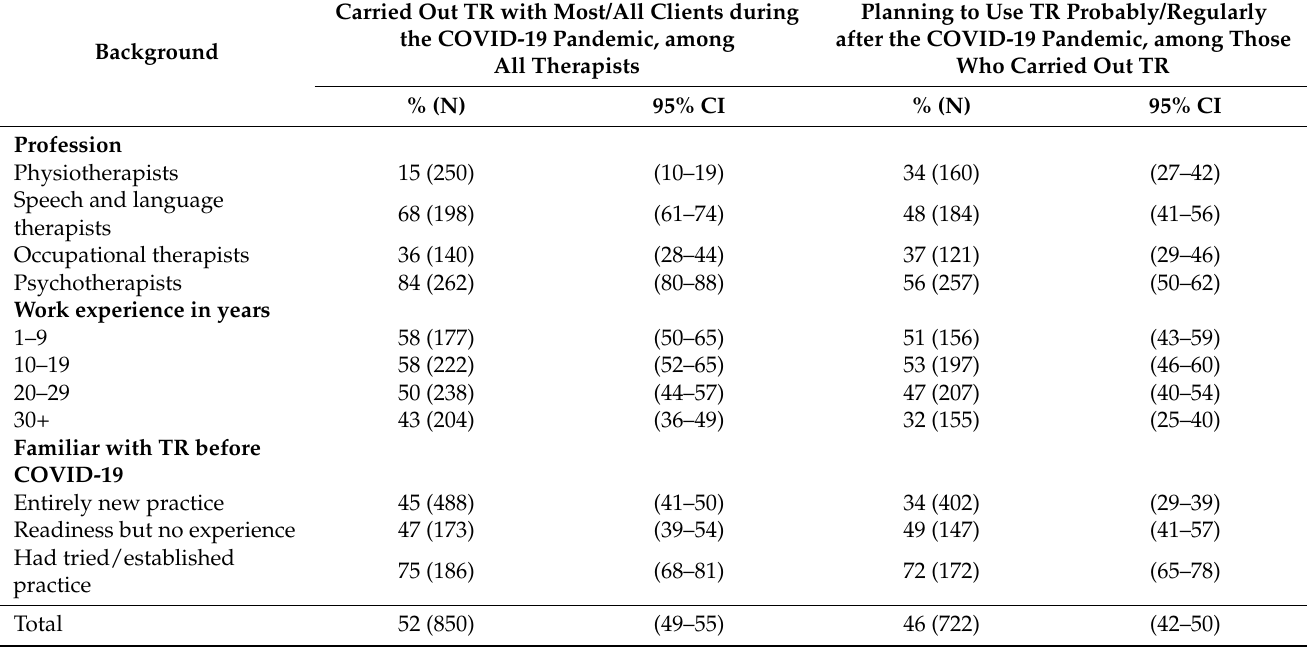
Table 2. Proportions of those who carried out tele-rehabilitation with most/all clients during the COVID-19 pandemic among all therapists and proportions of those who probably or regularly plan to use tele-rehabilitation also after the COVID-19 pandemic among those who carried out tele-rehabilitation, number, percentage (%) and 95% confidence intervals (CI).